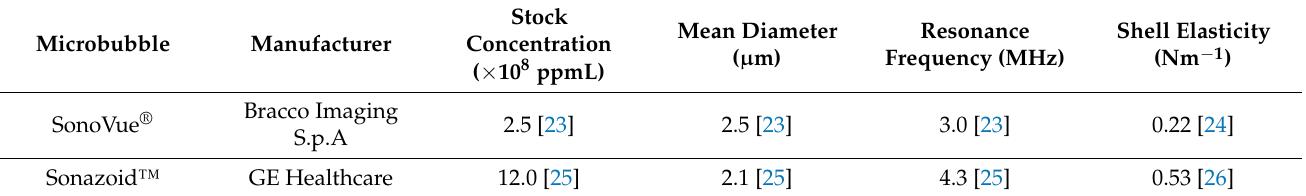
Table 2. Physicochemical characteristics of the two ultrasound contrast agents used in this study with study references in the